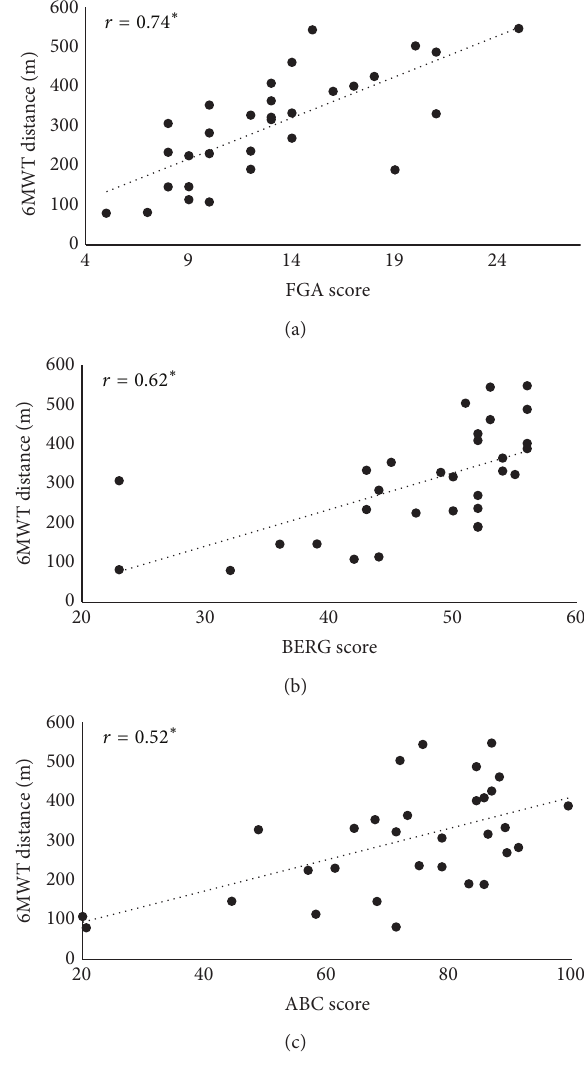
Figure 1: Scatter plots presenting the relationships before training between long-distance walking function (6MWT) versus walking balance (functional gait assessment (FGA), panel (a)), standing balance (Berg Balance Scale (BERG), panel (b)), and balance self- efficacy (Activities Specific Balance Confidence (ABC) Scale, panel (c)). Each of these variables was strongly related to long-distance walking function before training. ∗ = 𝑃 ≤ 0.05